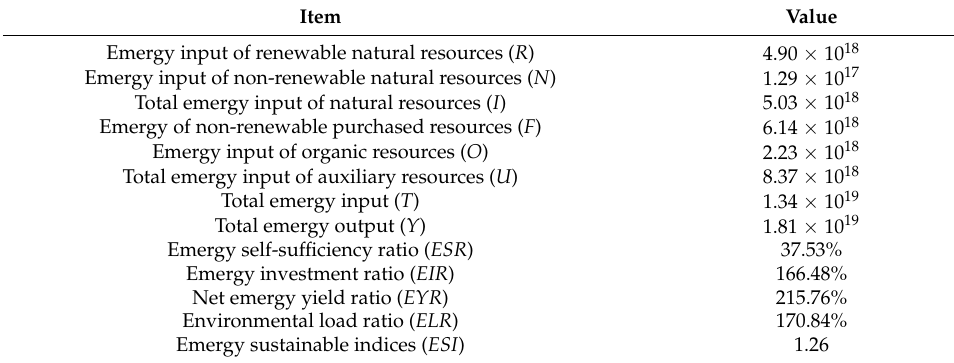
Table 5. Emergy evaluation index calculation of the cluster unit.